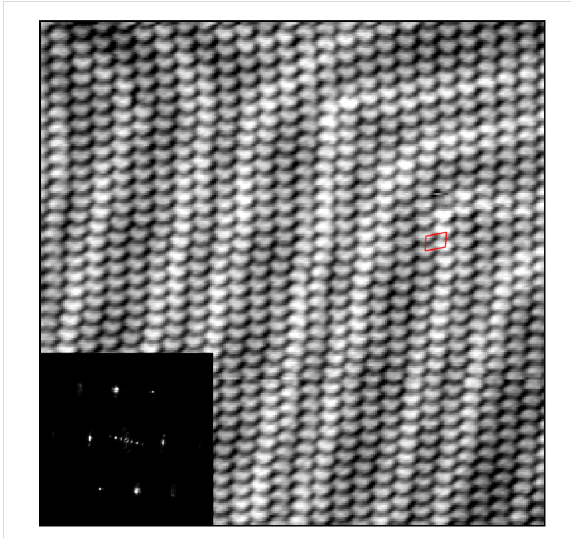
Figure 3: A 237 Å × 237 Å STM topography image acquired at a tip–sample bias of − 0.5 V, and a 5 pA setpoint. This image is a large array of 9,10-phenanthrenequinone rows, with the Au(111) herring- bone visible underneath. The inset is the 2D Fourier transform of the image, and the red overlay shows the periodicity obtained from the 2D